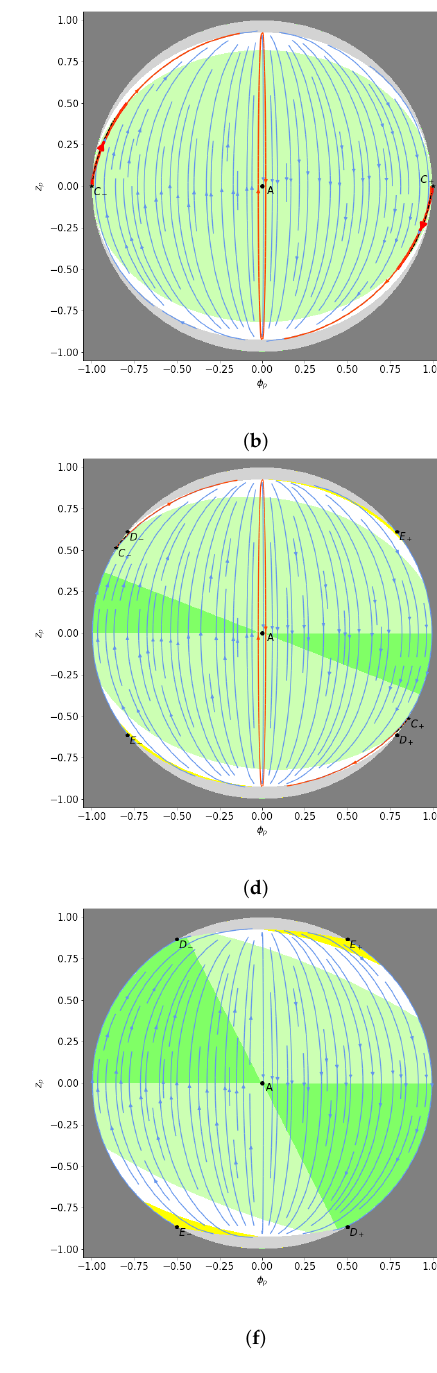
Figure 3. Cosmological dynamics of the quartic model (54) with Λ = 0, and ξ = 0 ( a , b ), ξ = 0.1 ( c , d ), ξ = 0.5 ( f ), ξ = 1 ( e ). Green background stands for superaccelerated, light green accelerated, white decelelerated, and yellow superstiff expansion, while grey covers the unphysical region. Orange trajectories are heteroclinic orbits between the fixed points, wider red part of the master trajectory highlights the 50 last e-folds of inflation, while red semi-transparent cover shows the basin of initial conditions leading to 50 e-folds. The dashed curve marks the path of slow roll approximation. For ξ > 0 and Λ 0 the system (55) and (56) has only one regular fixed point, → → A :